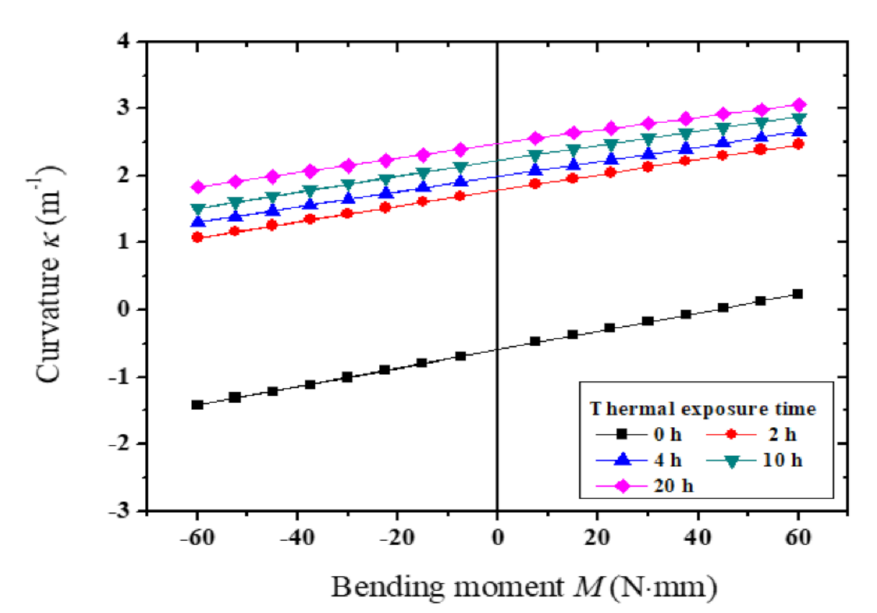
Figure 11. Relation curves between moment and